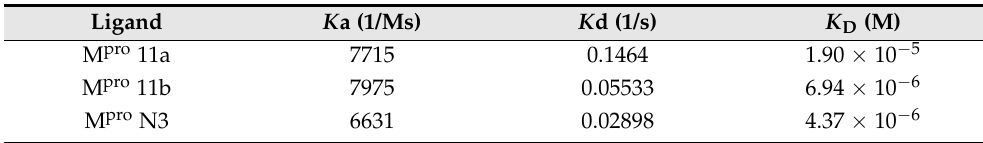
Table 1. M pro protein binding parameters ( K a, K d, and K D ) of known SARS-CoV-2 M pro inhibitors obtained from the SPR